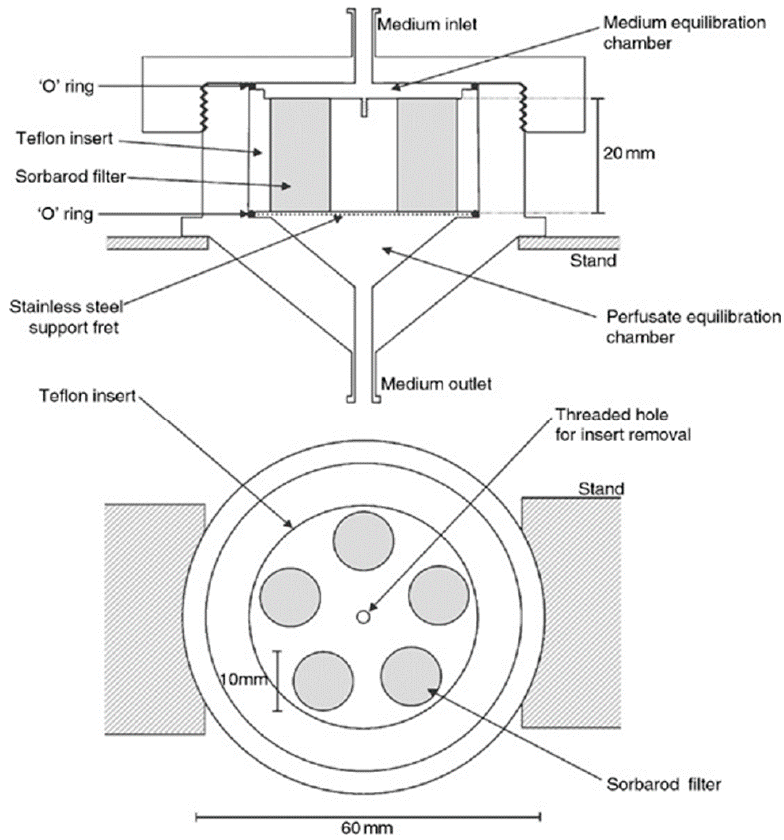
Figure 8. A schematic diagram of a multiple Sorbarod device (adapted from McBain et al., 2005 [41], with permission from © 2005 Wiley Online Library. License number: 4130790067572).